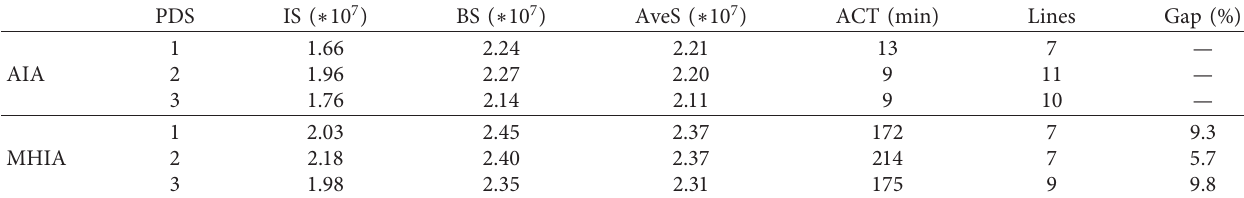
Table 7: Comparison between AIA and MHIA on medium HSR network.